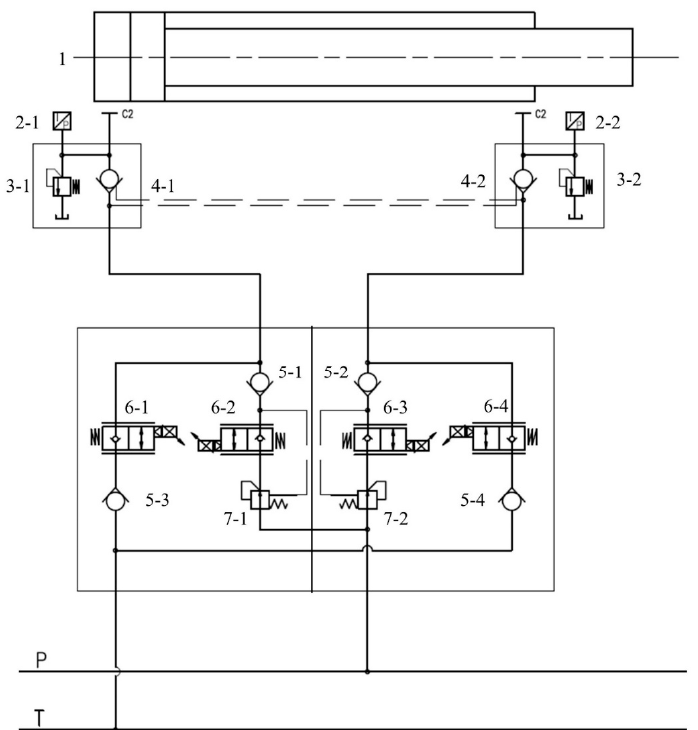
Figure 1. IMC valve-controlled hydraulic cylinder concrete pump boom system. 1. Hydraulic cylinder 2. Pressure sensor 3. Safety valve 4. Counterbalance valve. 5. Check valve 6. Proportional flow control valve 7. Pressure compensator.